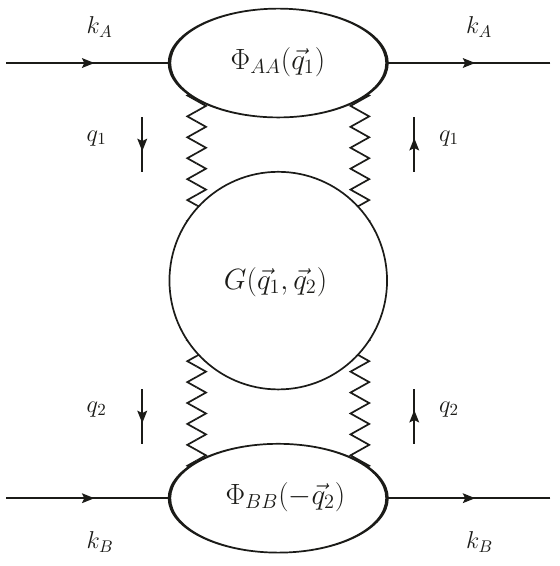
Figure 2 . Diagrammatic representation of the elastic scattering amplitude A + B → A + B